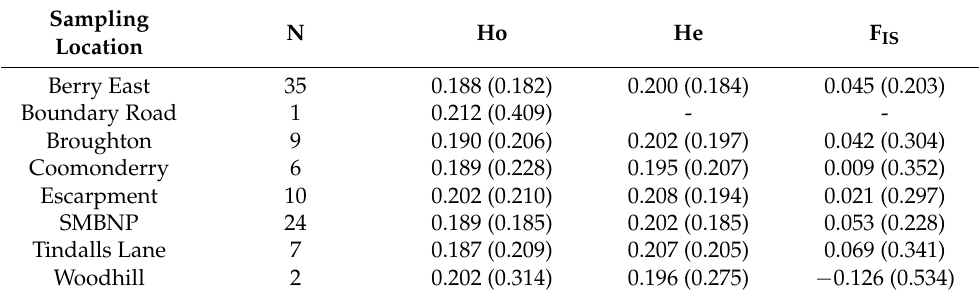
Table 1. Observed heterozygosity (H o ), expected heterozygosity (H e ), and inbreeding coefficient (F IS ) for 94 sugar glider individuals across eight sampling locations within the Berry Wildlife Corridor, Berry NSW, Australia. Total sample size of 94 individuals and calculations used 5999 SNPs in total. Standard deviation is shown in